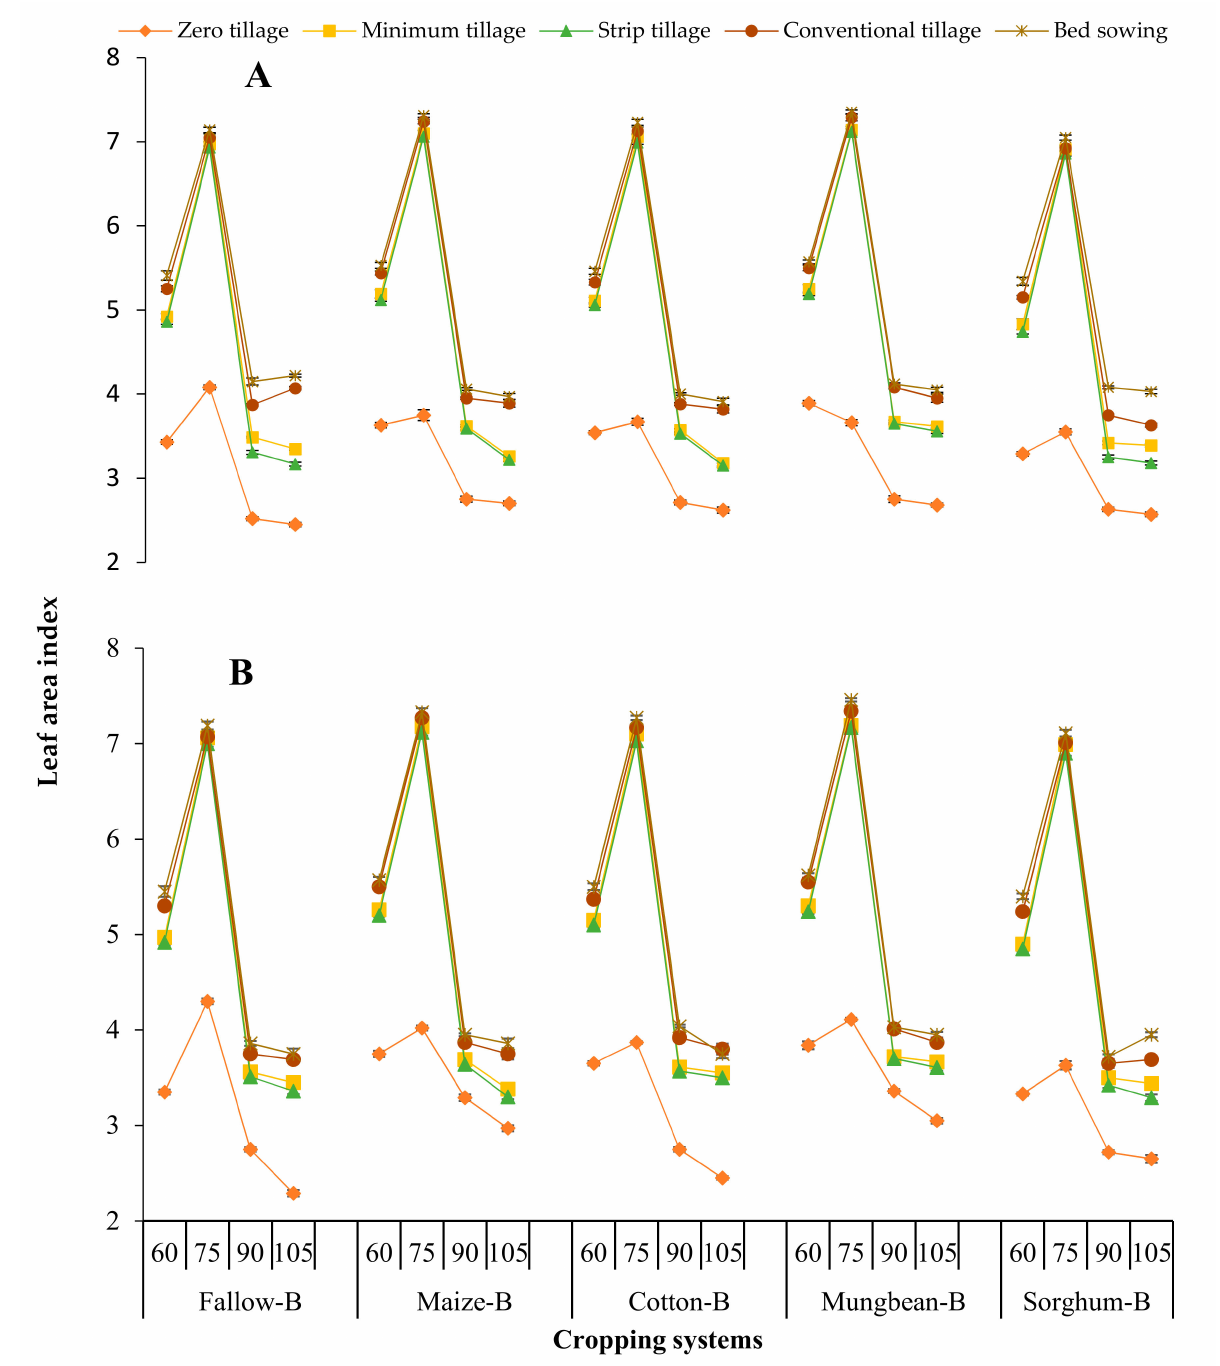
Figure 5. Interactive effect of tillage systems and barley-based cropping Scheme 2017. ( A ) and 2018–2019 ( B ) ± S.E. In the legend, Fallow-B = Fallow-barley, Maize-B = Maize-barley, Cotton-B = Cotton-barley, Mungbean-B = Mungbean-barley and Sorghum-B =